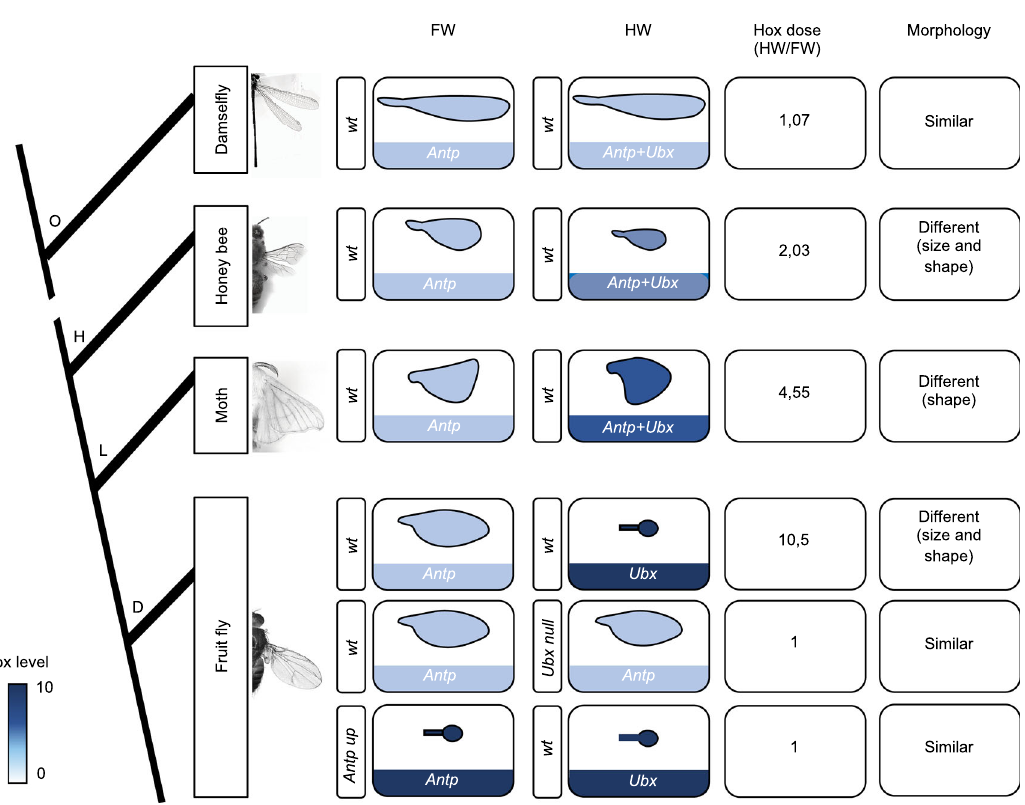
Fig. 9 Speculative model on Hox dosage variation and the evolution of fl ight appendages in insects. The model is based on the Hox (Antp or Antp + Ubx) expression level in the forewing (FW) and hindwing (HW) primordia. Ubx level was systematically considered as negligeable in the FW primordium of all studied species. Graded blue color depicts the Hox level (from light blue/low dose to dark blue/high dose). Note that although of similar colors, the doses are not comparable between the different species (RT-qPCR conditions and developmental stages were not identical). The total Hox dose when calculating the HW/FW ratio is indicated for each species, together with the corresponding morphological similarities or differences between the adult fl ight appendages. Note that morphological differences do not systematically correspond to size variation, as observed in B. mori that displays FW and HW of similar size, but of different shape. Genetic experiments in Drosophila showed that modifying the Hox dose by abolishing Ubx (which induces the derepression of Antp) or increasing Antp could respectively transform the haltere or the wing into a wing or a haltere. In both cases, similar Hox levels led to similar fl ight appendages on the T2 and T3 segments. The speci fi c expression pro fi le of Antp in the pouch of the wing disc or in the haltere-to-wing transformed disc (not schematized in the fi gure) also indicates that the spatial pro fi le is likely not neutral in addition to the dose. O Odonata, H Hymenoptera, L Lepidoptera, D